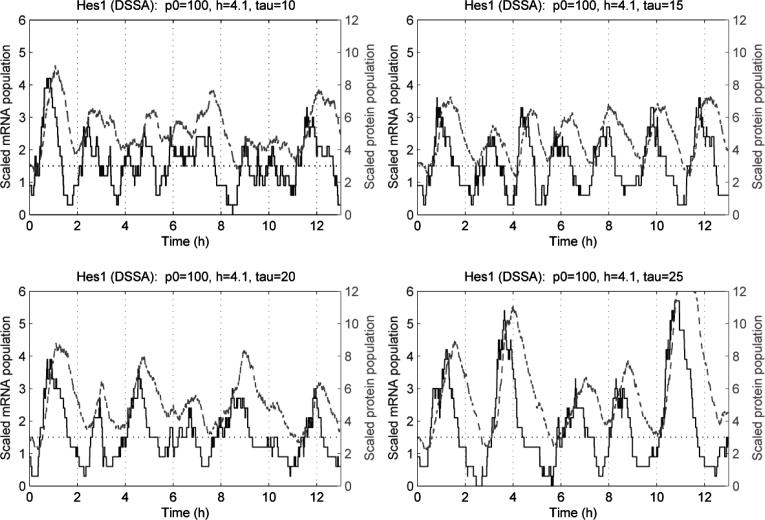
DSSA Simulations: Exploring the Effects of DelayThe horizontal dotted line marks P
0, mRNA is represented by the solid line, and protein by the dashed line.